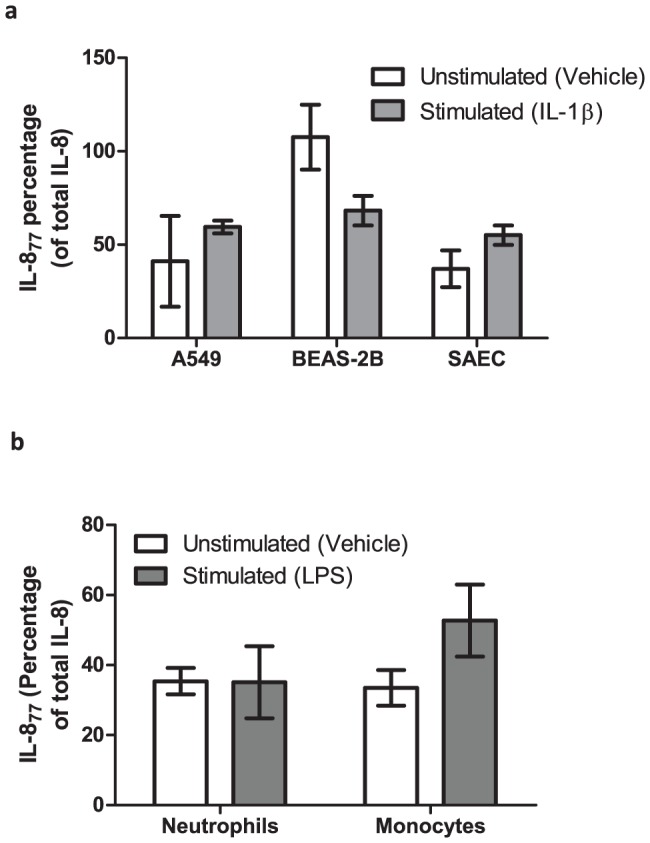
Expression of IL-877 from cultured cells.Proportion of IL-877, expressed as a percentage of total IL-8, from un-stimulated (open bars) and stimulated (shaded bars) (a) airway epithelial cells and (b) term cord-blood neutrophils and monocytes. Cells-types are represented on the x-axis while percentage of IL-877 is represented on the y-axis. Bars are means (± SEM) of three independent cell-culture experiments, each conducted in duplicate. All supernatants were separately measured by ELISA in duplicate.